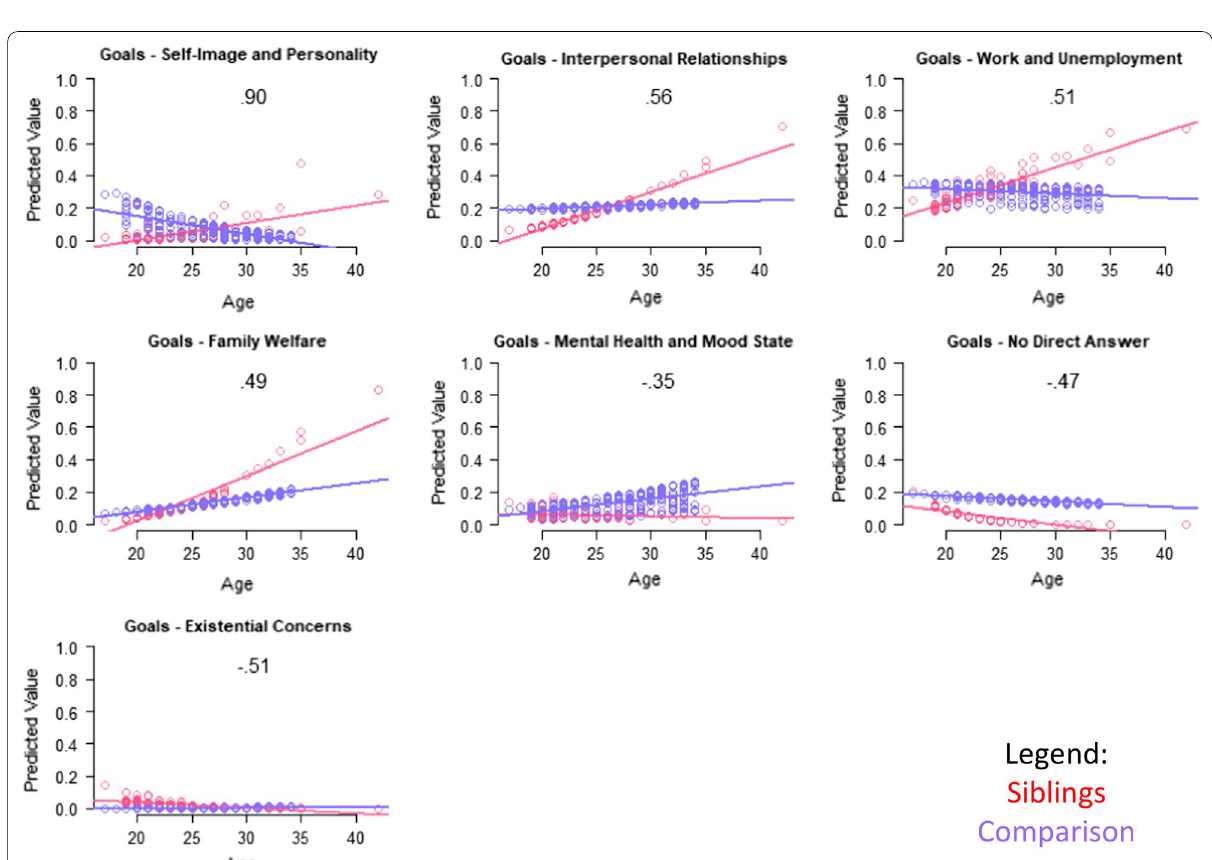
Fig. 4 Interaction plots for adjusted logistic models predicting Goal themes. Role-group differences for medium- and large-ES interaction effects are shown. Sibling predicted values are shown in red; comparison in